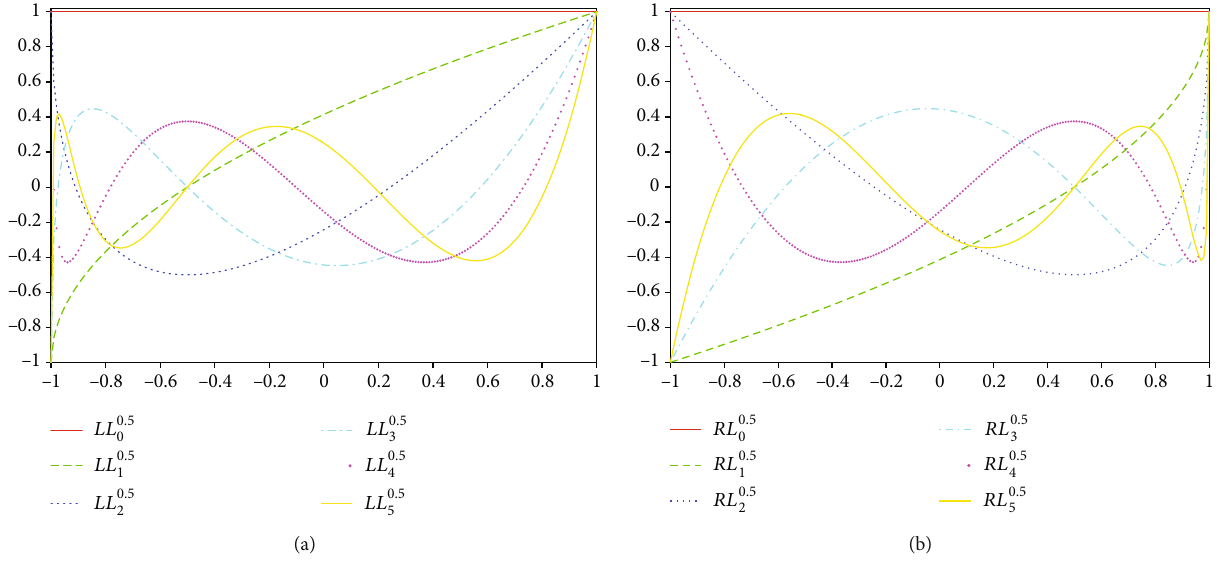
Figure 1: (a) The fi rst six terms of the left SFLPs for α = 0 : 5 . (b) The fi rst six terms of the right SFLPs for α = 0 : 5 .